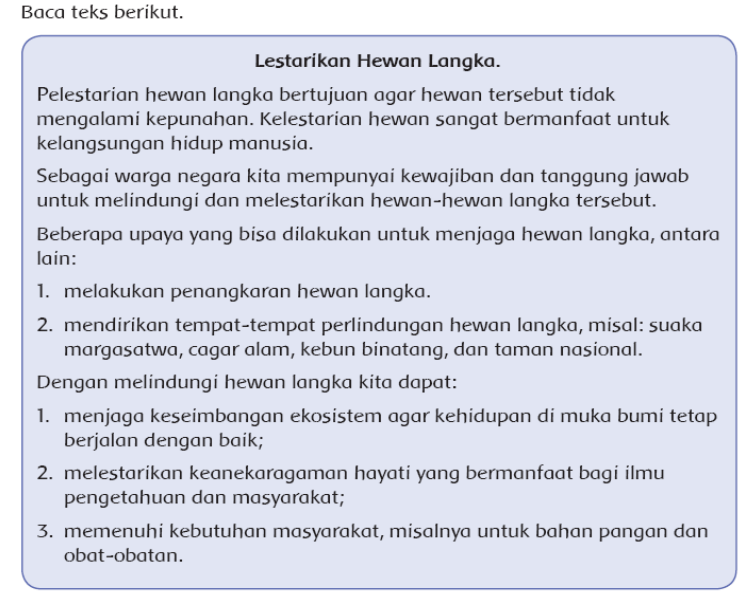
Figure 18 : The story maintains the sustainability of rare animals